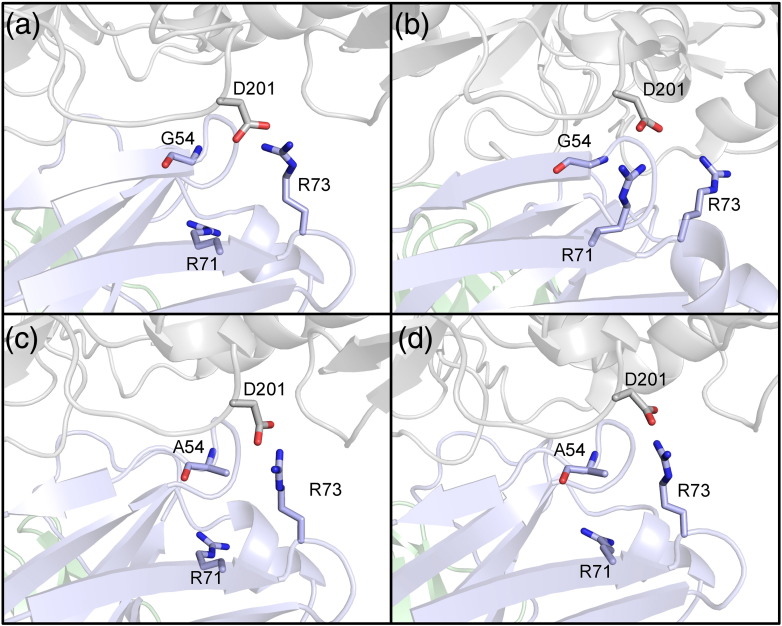
First and last frames of the (a to b) wild-type and (c to d) mutant phases for the VRC-PG04 G54 mutation using the PLOP-predicted starting structure. (b) The wild-type phase regains the contact with the gp120 residue shown, which is found for the crystal structure-based homology model and wild-type loop prediction. (c and d) The mutant phase system maintains the contact between R73 and the gp120 residue because the contact involving R71 is now prevented by the alanine side chain.